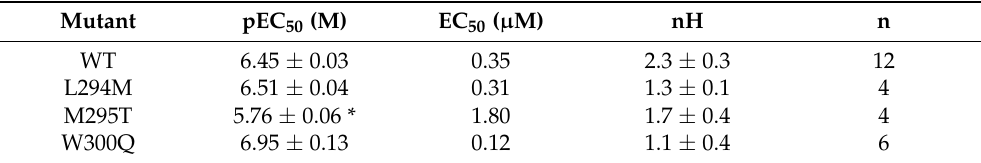
Figure 3. A multiple sequence alignment reveals several residues in M1 differ in α subunits but are conserved across other GABA A R subunits. The alignment was generated by Clustal Omega from the M1 regions of the 19 GABA A R subunits (the residue number shown is for the GABA A ρ 1 subunit). Residues conserved between the GABA A ρ 1 subunit and a given subunit are dark grey, residues with similar general properties to their GABA A ρ 1 subunit equivalent are light grey, and non-conserved residues are pink. Table 3. Parameters derived from concentration – response curves of GABA A ρ 1R after substitution with GABA A R α subunit M1 residues. Table 3. Parameters derived from concentration–response curves of GABA A ρ 1R after substitution with GABA A R α subunit M1